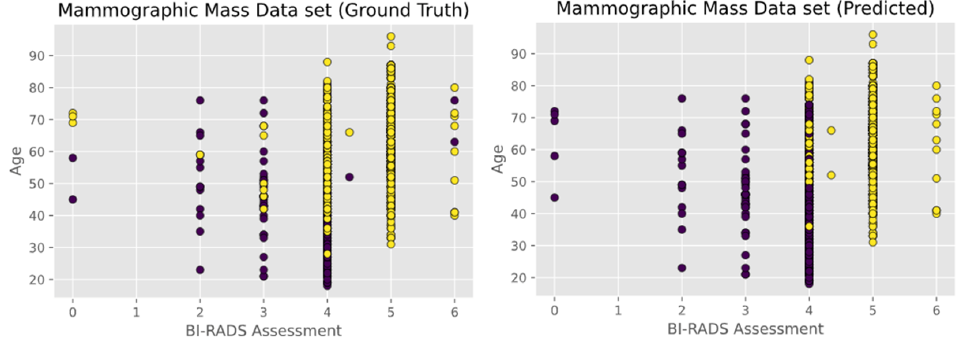
Figure 18. Ground truth vs. predicted labels from FNN-PSO algorithm on Mammographic Mass